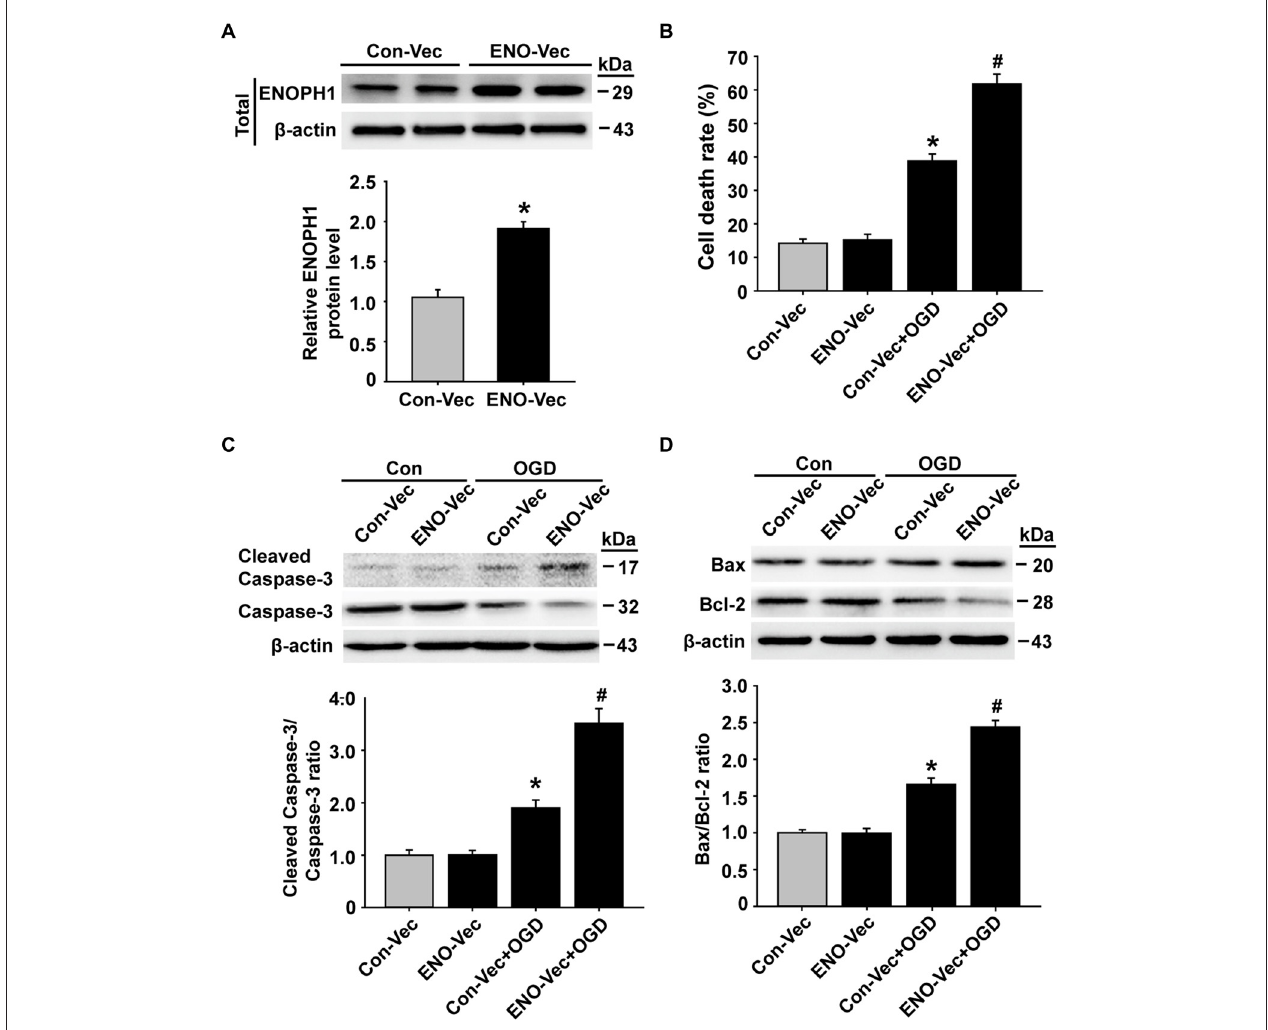
FIGURE 6 | Overexpression of ENOPH1 aggravates OGD-induced apoptosis in bEND3 cells. (A) The ENOPH1 CRISPR activated plasmid effectively increased ENOPH1 protein expression in bEND3 cells. Upper panel: representative immunoblots showing the changes of ENOPH1 protein bands in bEND3 cells after 6 h OGD treatment, with or without ENOPH1 CRISPR activated plasmid (ENO-Vec) transfection; bottom panel: quantitative data showed that transfecting cells with ENO-Vec for 48 h significantly enhanced ENOPH1 protein levels ∗ P < 0.05 vs. control activated plasmid (Con-Vec); n = 4. (B) ENOPH1 overexpression significantly increased 6 h OGD induced cell death assessed by lactate dehydrogenase release. ∗ P < 0.05 vs. Con-Vec; # P < 0.05 vs. Con-Vec + OGD; n = 4. (C) Upper panel: representative immunoblots showing the changes of cleaved and full length caspase-3 protein bands in bEND3 cells. β -actin was used as a loading control; bottom panel: quantitative data showed that OGD significantly increased the cleavage of caspase-3 and PARP and overexpression of ENOPH1 aggregated this change. ∗ P < 0.05 vs. Con-Vec; # P < 0.05 vs. Con-Vec + OGD; n = 4. (D) Upper panel: representative immunoblots of Bax and Bcl-2 proteins; bottom